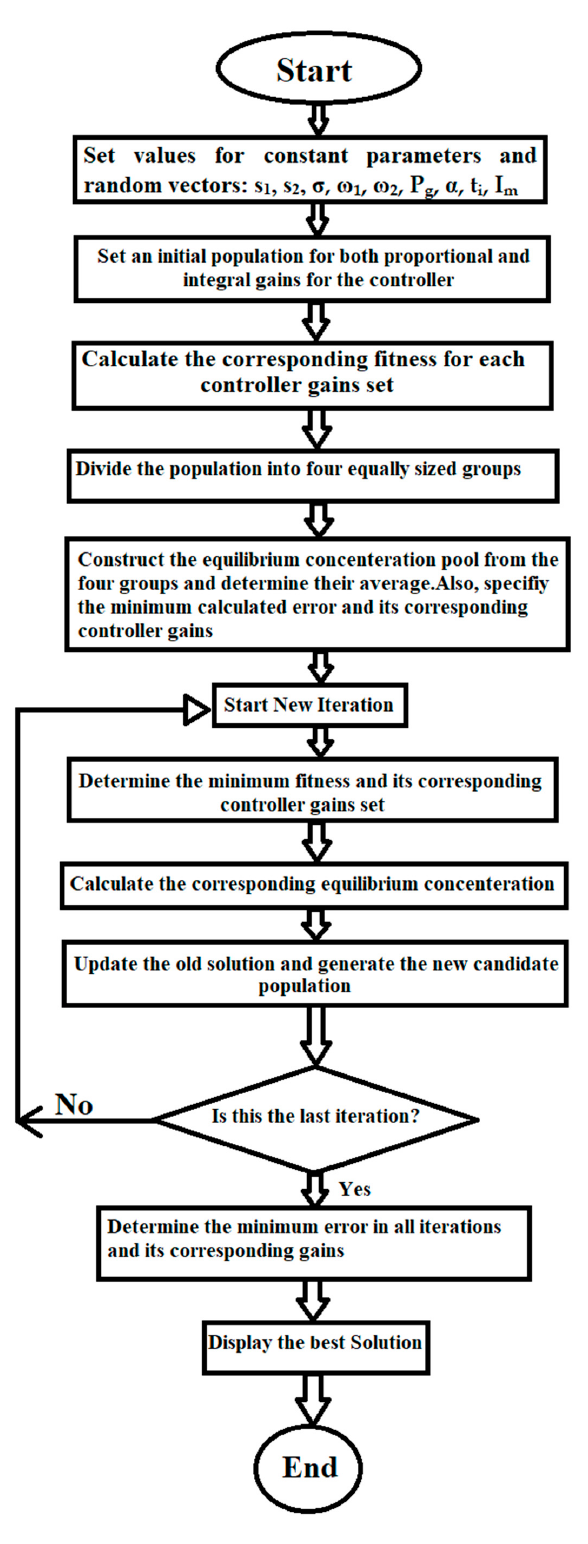
Figure 3. Flowchart of EO algorithm.